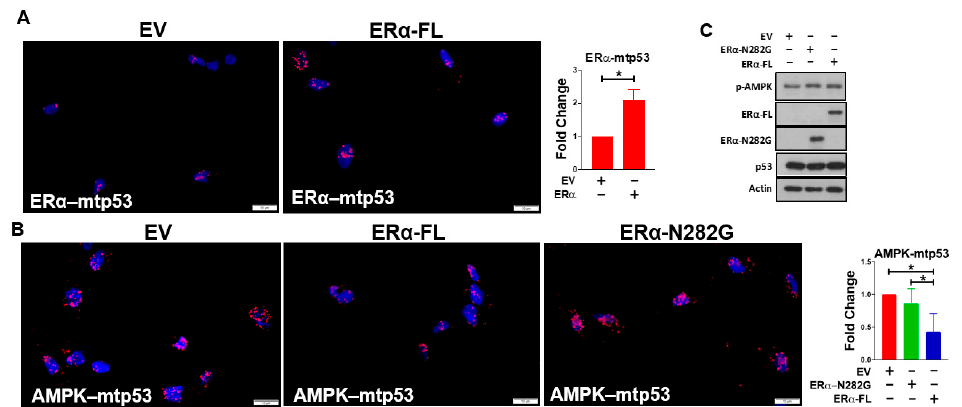
Figure 2. ER α impairs mutant p53’s ability to bind to AMPK. MDA-MB-231 cells were transfected with ER α -FL (full length), ER α -N282G (truncated at aa282, thus lacking the domain required for p53 interaction) or empty vector to assess the impact of ER α on mutant p53-AMPK interactions using the PLA. PLA ( A ) for Er α –mutant p53 interaction and ( B ) for AMPK–mutant p53 interaction. Further, immunoblotting analysis was performed to determine whether the expression of ER α altered AMPK phosphorylation in the MDA-MB-231 cells ( C ). PLA interactions were assayed for the following interacting pairs: total-AMPK-mtp53 and ER α -mtp53. The interactions were quantified and the graphed values reflect mean ± standard deviation of at least 3 biological replicates. * p -value < 0.05 demonstrates statistical significance by Student’s t -test ( A ) or by One-way ANOVA ( B ). Quantitation of protein levels of p-AMPK, ER α , and p53 (Figure 2C) are shown in Figure S2C. PLA: proximity ligation assay; aa: amino acid; EV: Empty vector. Prior studies from our lab identified that the c-terminal domain (CTD) of ER α (aa283– 595) is required for binding p53 [29]. The deletion mutant N282G ER α protein in which